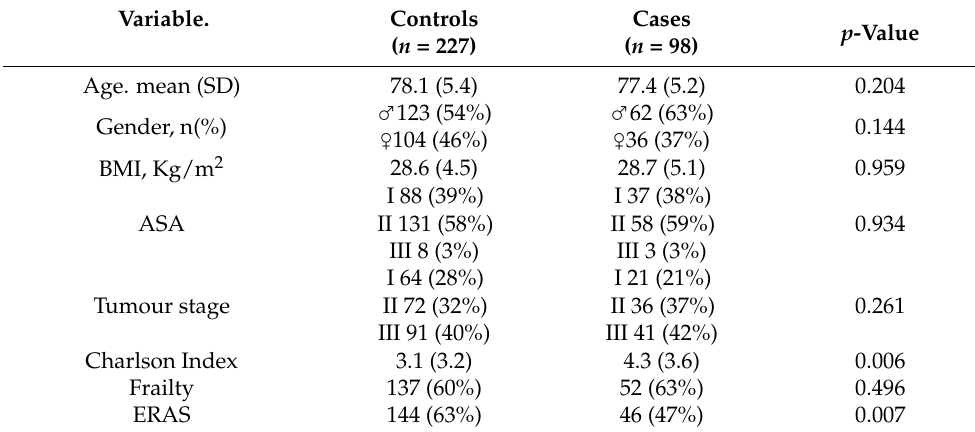
Table 1. Bivariate analysis of cases and controls during hospital admission. Baseline situation of cases and controls at hospital admission.